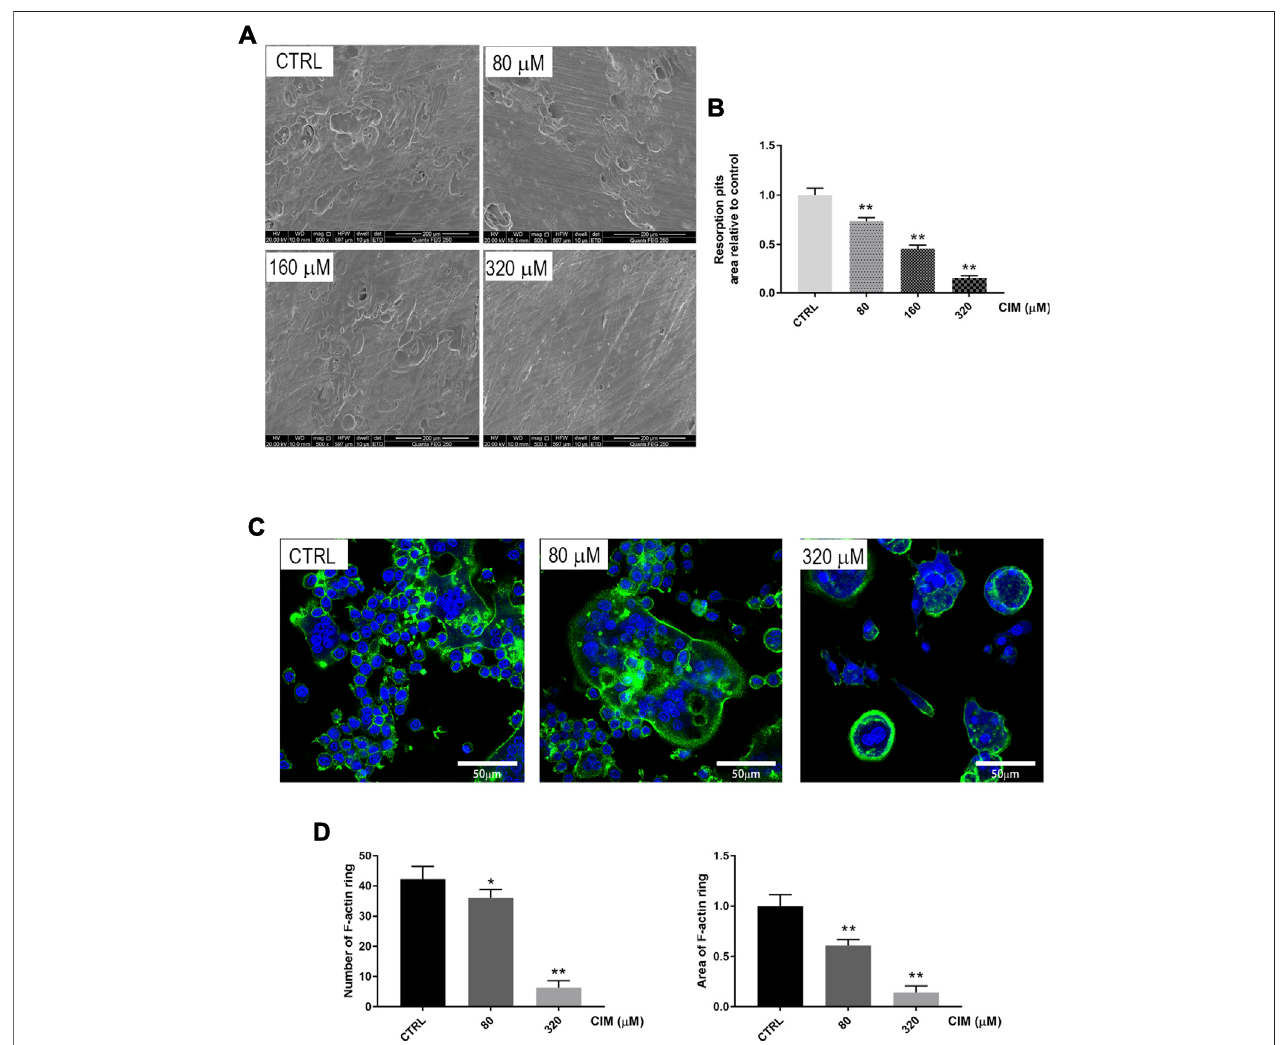
FIGURE 2 | Noncytotoxic CIM dose-dependently mitigates the bone-resorbing activity of osteoclasts in vitro . (A) Scanning electron microscopy images of eroded surfaces on bone slices treated with CIM at the indicated concentrations. (B) The areas of bone resorption pits relative to the control group are shown. (C) Immuno fl uorescenceimagesofF-actinrings(ingreen)inBMM-derivedosteoclaststreatedwithCIMattheindicateddoses.(**: p < 0.01comparedwiththecontrolgroup). (D) Number and area of F-actin ring were counted via Image J Software.